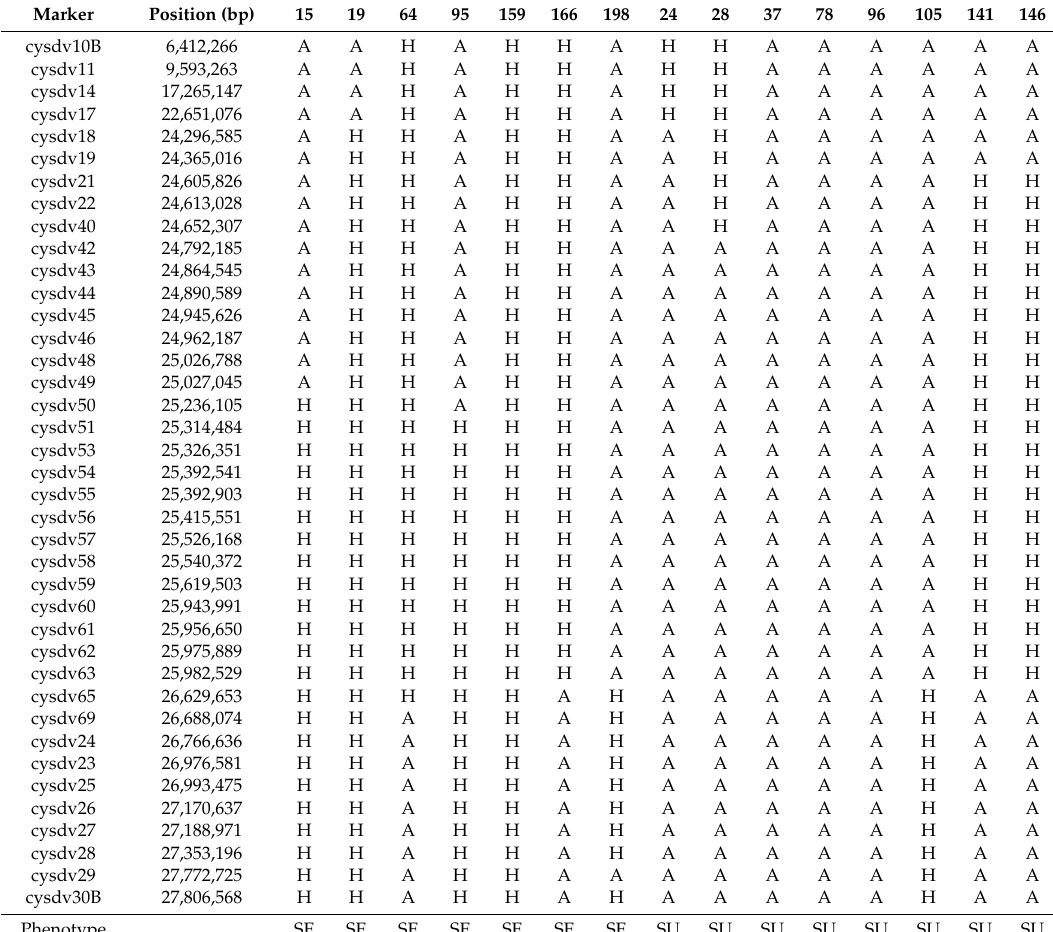
Table 4. Genotype for SNPs in marker sets CYSDV1 and CYSDV2 for the BC 3 plants selected to evaluate their descendants (A: homozygous for ‘Bola de Oro’ allele; H: heterozygous). The phenotype of the progenies is indicated (SU: susceptible; SE: